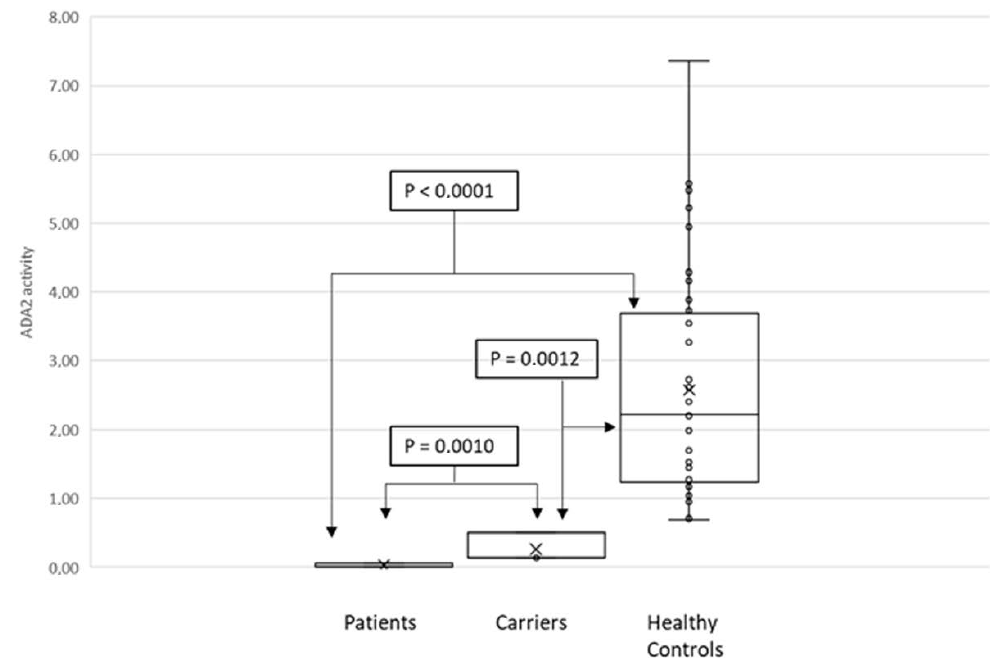
Figure 2. Mann–Whitney tests of ADA2 activity from patients versus carriers ( p = 0.0010), from patients versus healthy controls ( p < 0.0010), and from carries versus healthy controls ( p =